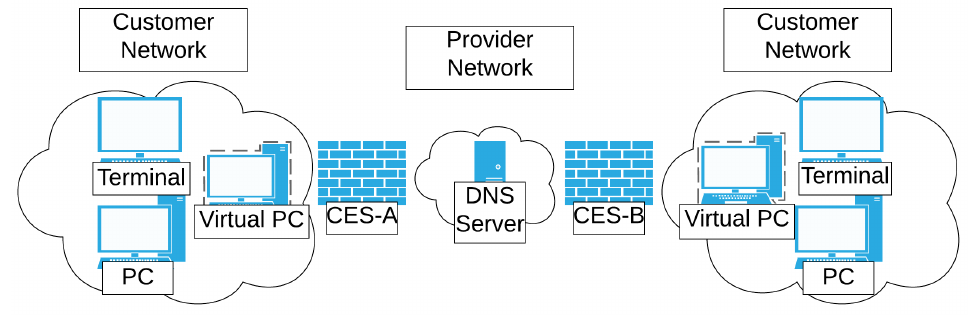
Figure 1. Customer Edge Switching Architecture [8].